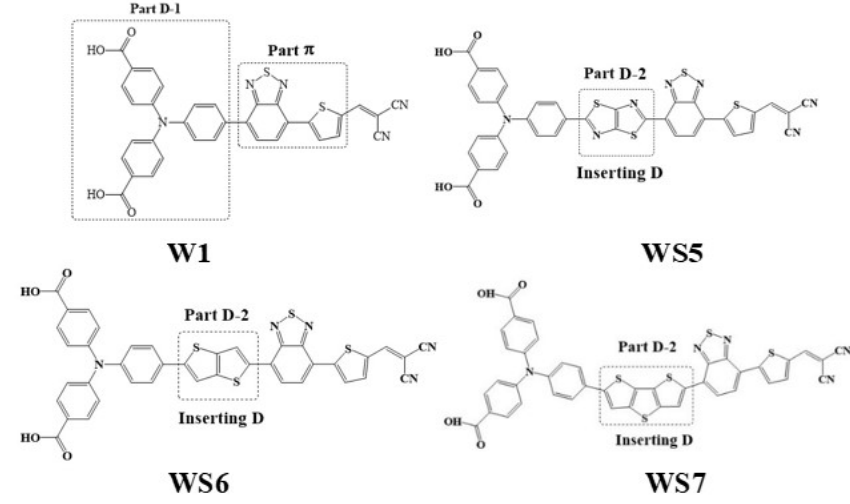
Figure 1. Structures of W1, WS5, WS6, and WS7 molecules.